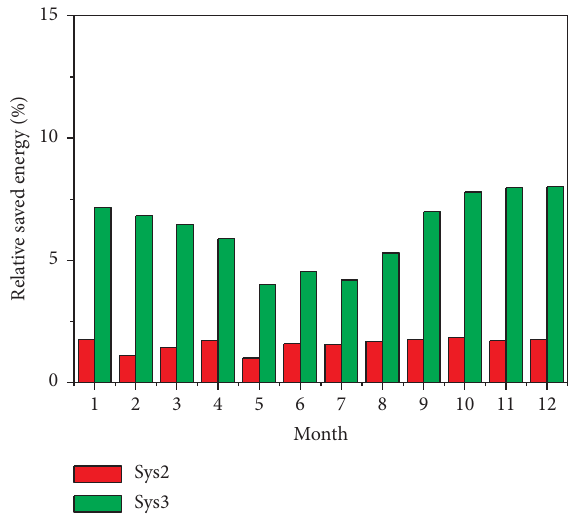
Figure 14: Relative saved energy for the two systems, 2 and 3, in each month (number of offices � 1).